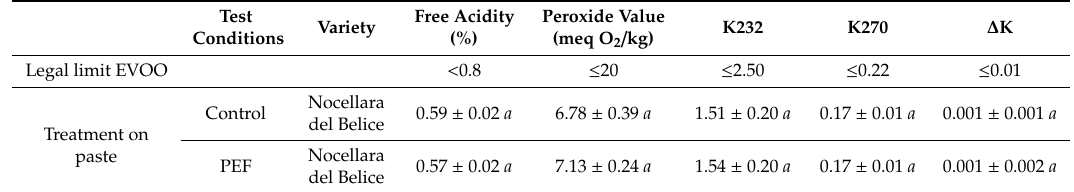
Table 2. Standard virgin olive oil parameters specified by the International Olive Council (IOC, 2017). EVOO: extra virgin olive